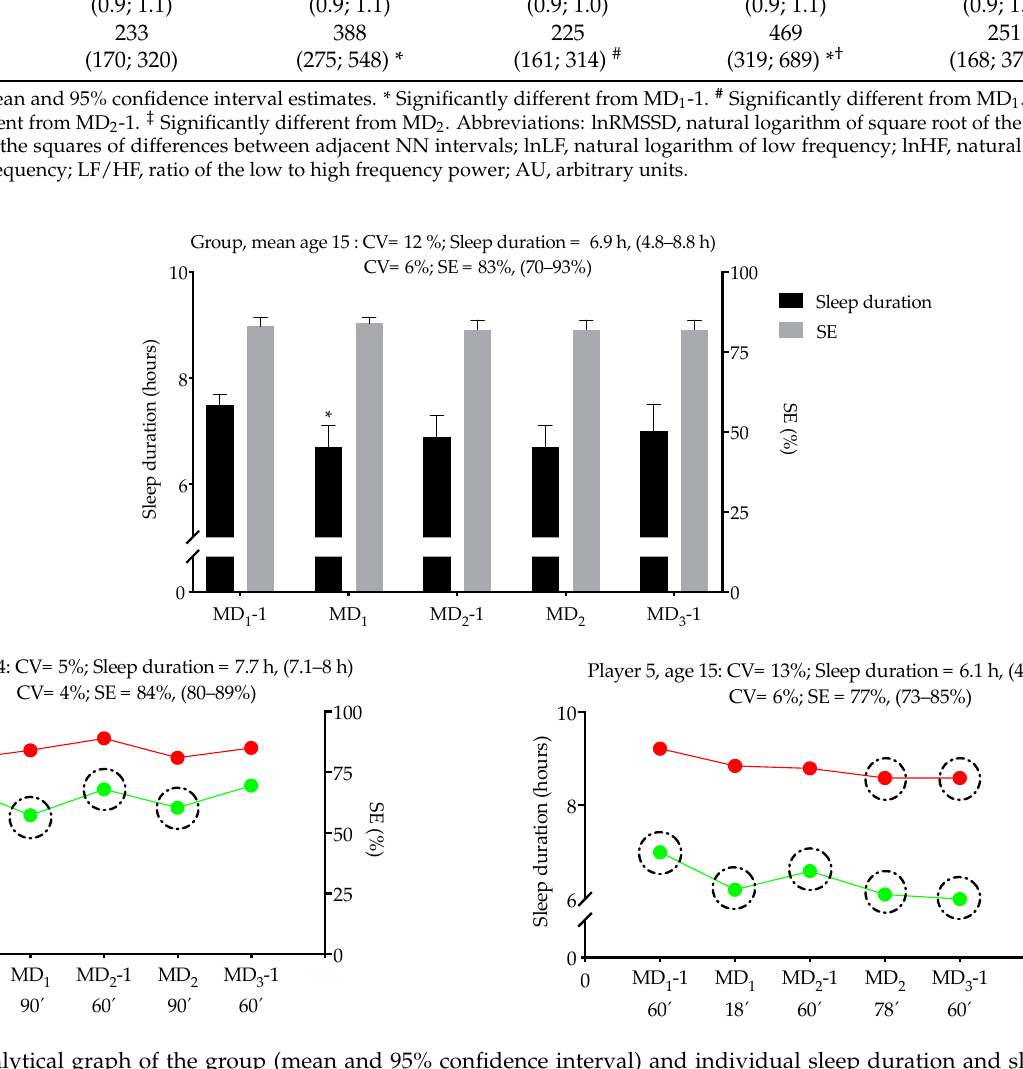
Figure 2. Analytical graph of the group (mean and 95% confidence interval) and individual sleep duration and sleep efficiency (SE) values of two players during the 5 days of the tournament. Averages, maximum and minimum values are also presented. Green and red dots represent daily changes in sleep duration and SE, respectively. The black dashed circumferences represent the days where sleep duration and SE were lower than the recommended amounts (i.e., sleep duration < 8 h and SE < 75%). Abbreviations: MD, Match-day; TST, total sleep time; CV, coefficient of variation. * Significantly different from MD 1 -1 ( p = 0.03).